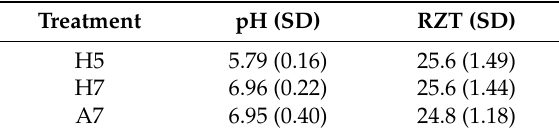
Table 3. Tub means and standard deviation (SD) of pH and root zone temperature (RZT, ◦ C) by treatment.